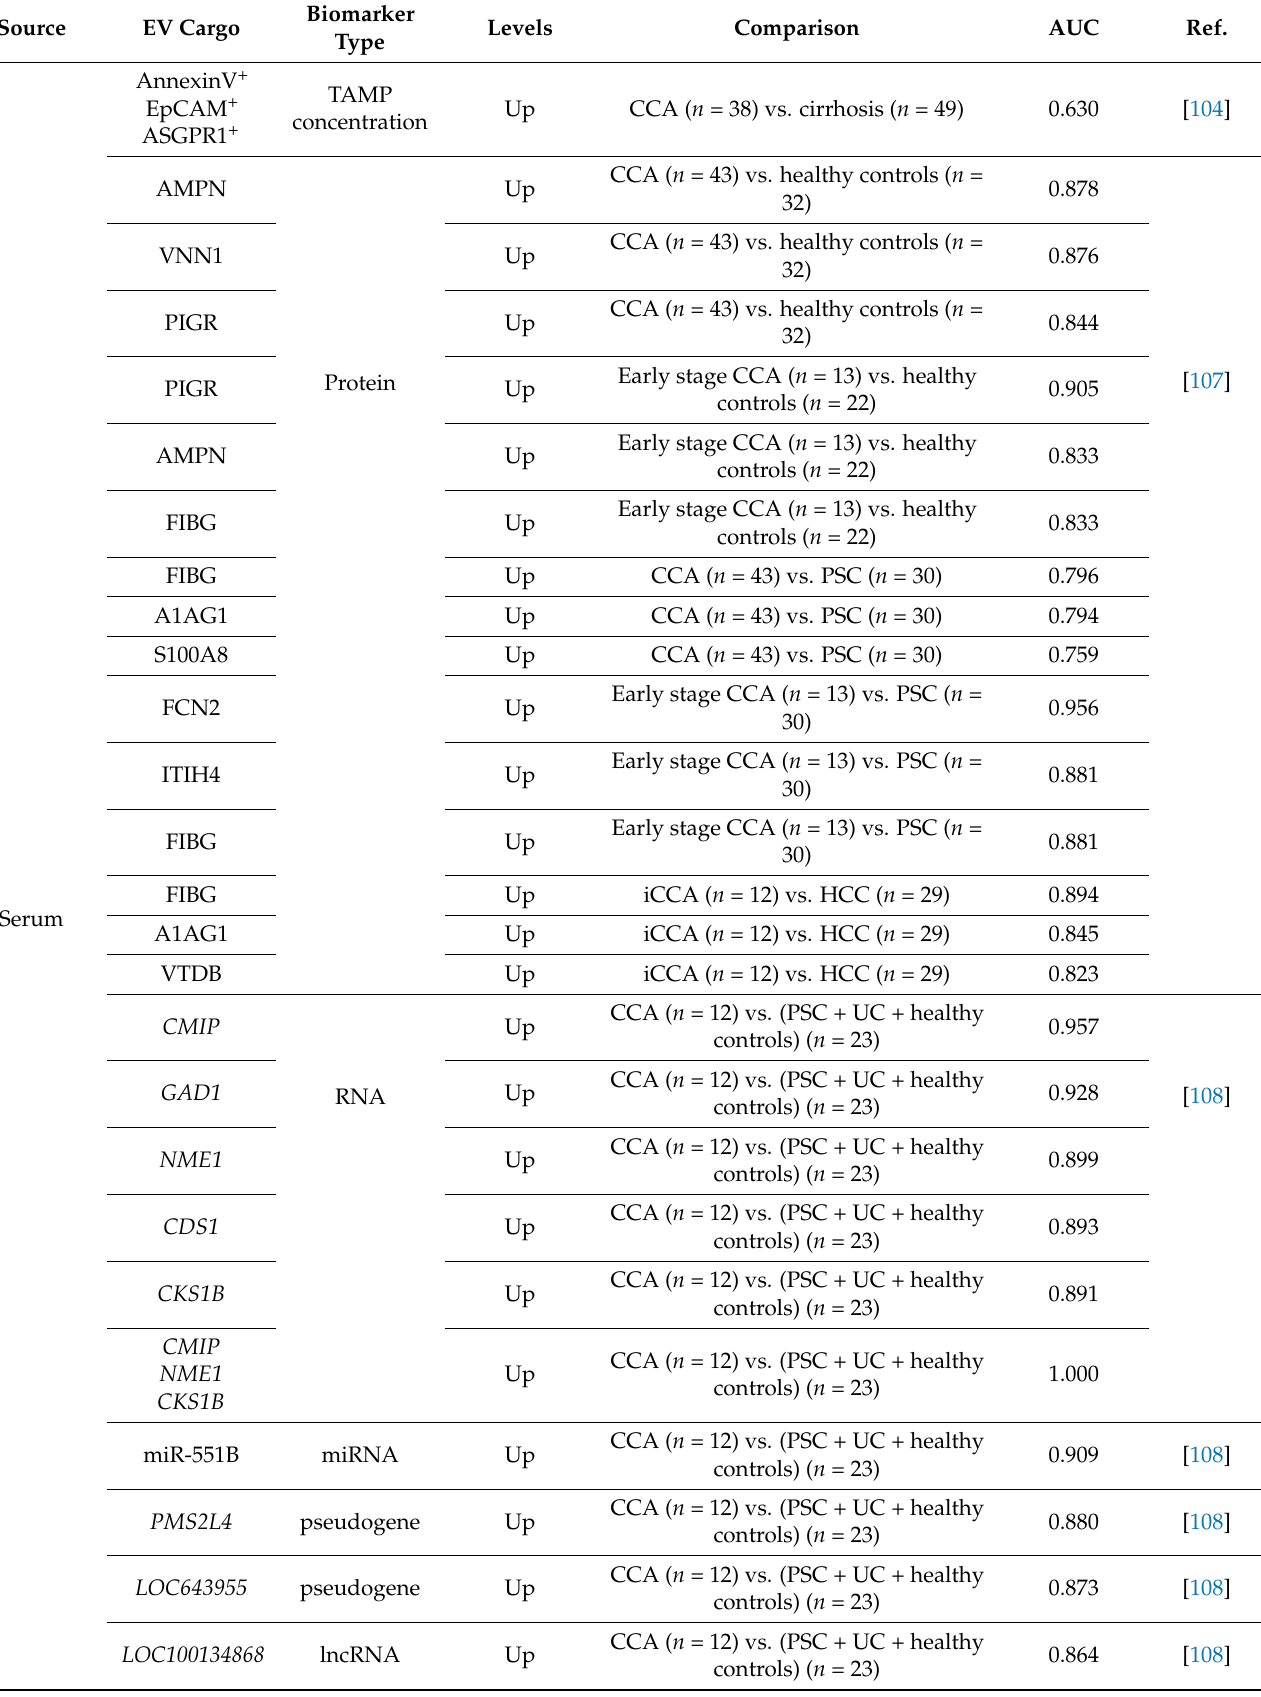
Table 4. Circulating extracellular vesicles containing biomolecules with potential diagnostic value for